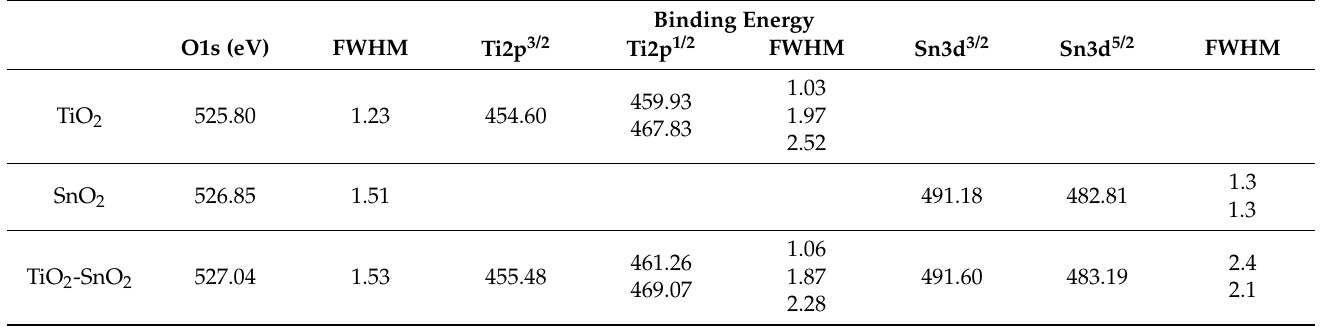
Table 1. Consolidated XPS characteristic peaks of TiO 2 , SnO 2 , and composite TiO 2 -SnO 2 nanofibers. Binding